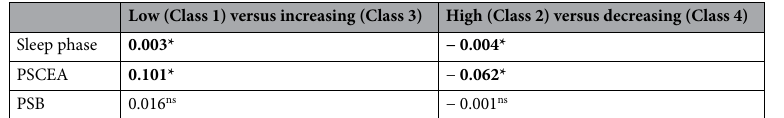
Table 4. The influence of sleep phase and pre-sleep cognitive-emotional arousal and behavior on class membership, using multinomial logit regressions. Displayed are the predictors’ effects on the increasing Class 3, with the low Class 1 as reference, and the decreasing Class 4, with the high Class 2 as reference. Unstandardized coefficients are shown. The predictors are measured at baseline (T1). ns non-significant at p < 0.05 level, PSCEA pre-sleep cognitive-emotional arousal, PSB pre-sleep behavior. * p < 0.05 . Significant values are in